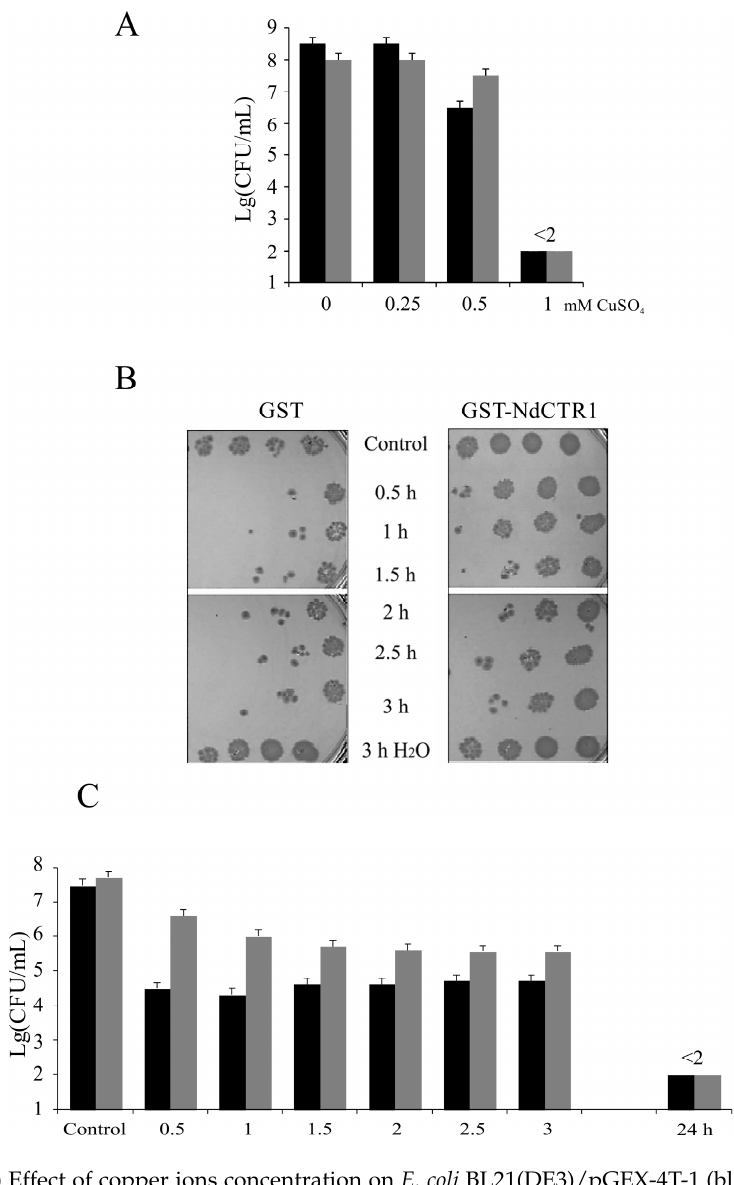
Figure 2. ( A ) Effect of copper ions concentration on E. coli BL21(DE3)/pGEX-4T-1 (black bars) and E. coli BL21(DE3)/pNdCTR1 (grey bars) after 24 h of treatment. Abscissa: CuSO 4 concentration, mM; ordinate: CFU, lg. ( B ) Effect of time on survival of E. coli BL21(DE3)/pGEX-4T-1 and E. coli BL21(DE3)/pNdCTR1 treated with 0.25 mM copper ions (protocol of the experiment). ( C ) Bar graph corresponding to the ( B ) experiment repeated three times. Black bars: E. coli BL21(DE3)/pGEX-4T-1; grey bars: E. coli BL21(DE3)/pNdCTR1.